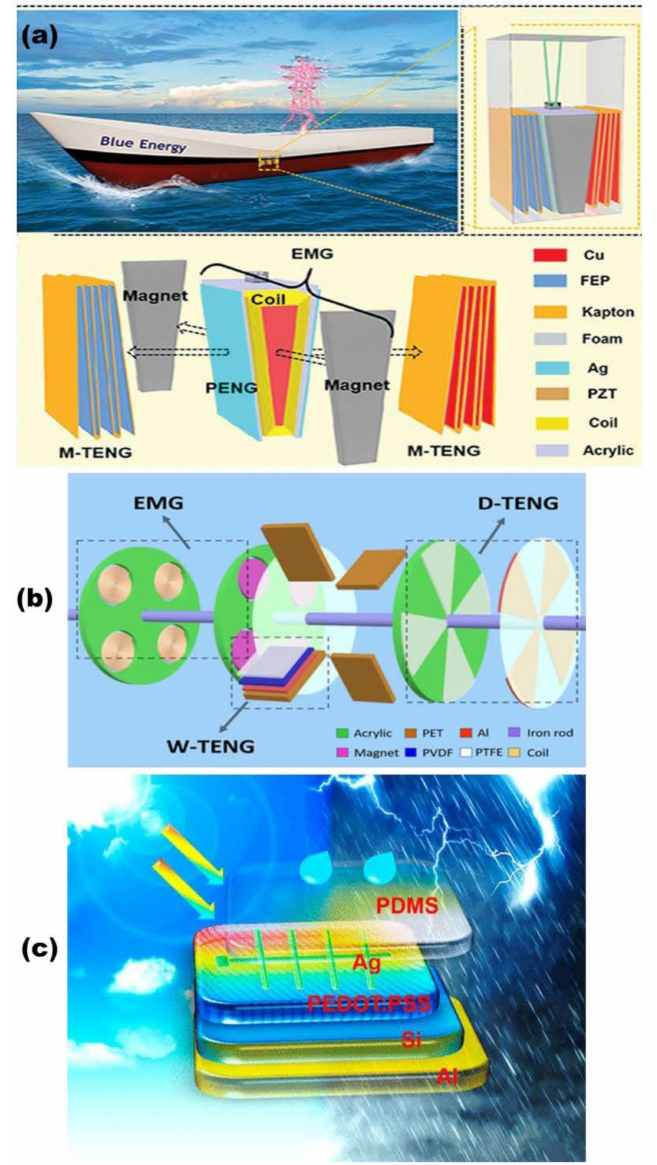
Figure 10. ( a ) Schematic diagram of bifilar-pendulum coupled hybrid nanogenerator (reproduced with permission from [151]. Copyright 2022, Wiley-VCH GmbH, Weinheim, Germany). ( b ) Schematic diagram of the rotating hybridized TENG (reproduced with permission from [128]. Copyright 2017 WILEY-VCH Verlag GmbH & Co. KGaA, Weinheim, Germany). ( c ) The hybrid nanogenerator that integrates a solar cell and a TENG (reproduced with permission from [152]. Copyright 2018, American Chemical Society, New York, NY,